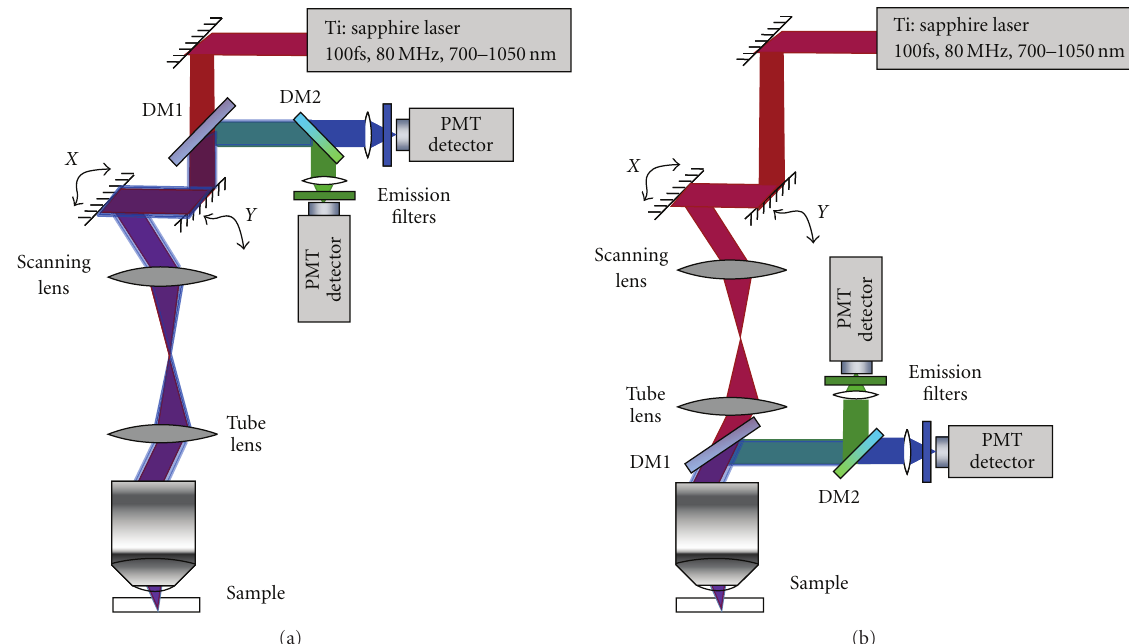
Figure 2: Schematic of elements of a multiphoton imaging optical setup. (a) Descanned detection whereby the emitted signal is collected after travelling back through the scanning mirrors. (b) Nondescanned detection. DM indicates dichroic mirror.